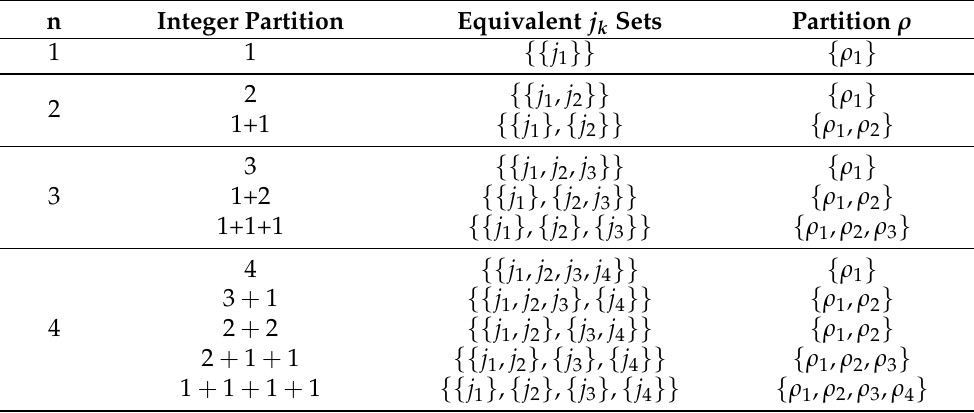
Table 1. Integer partition and the sets of j k objects equivalency.